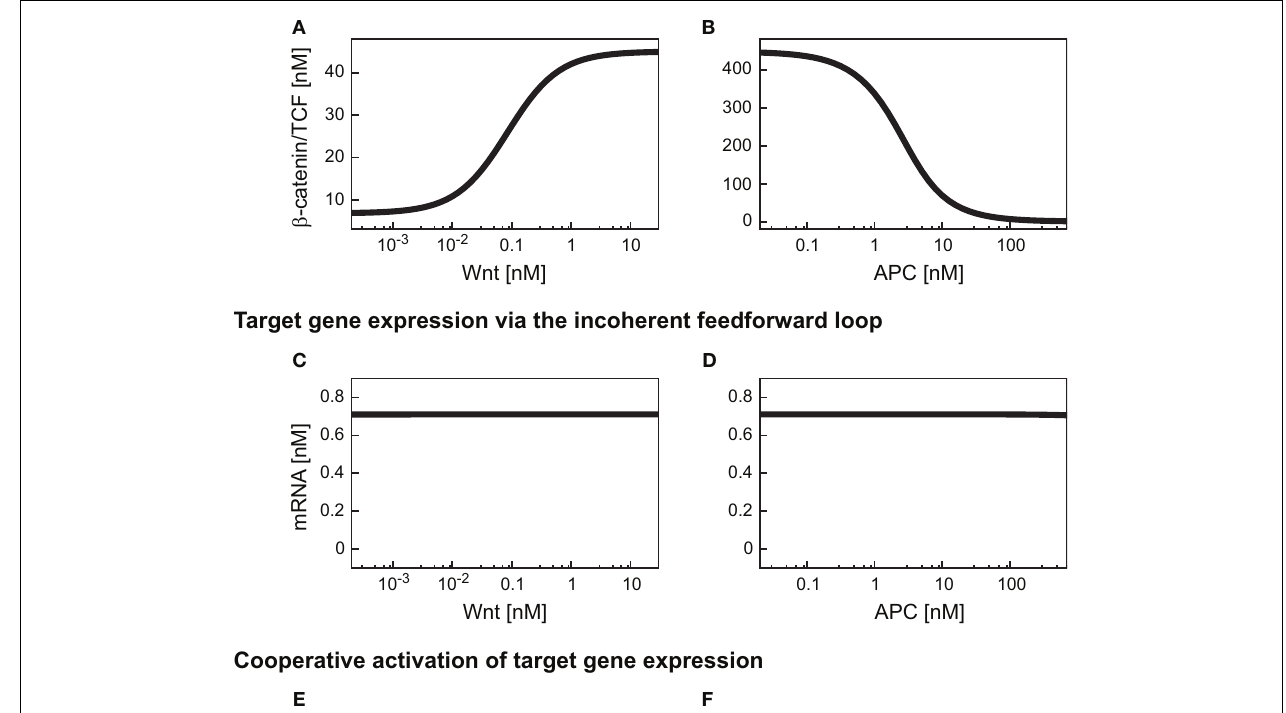
genes induced by an iFFL motif (C,D) , induced by cooperative activation with the Hill coefficient n = 3 (E,F) , and upon inhibition (G,H) are shown within (C,E,G) aWnt gradient or (D,F,H) an APC gradient.